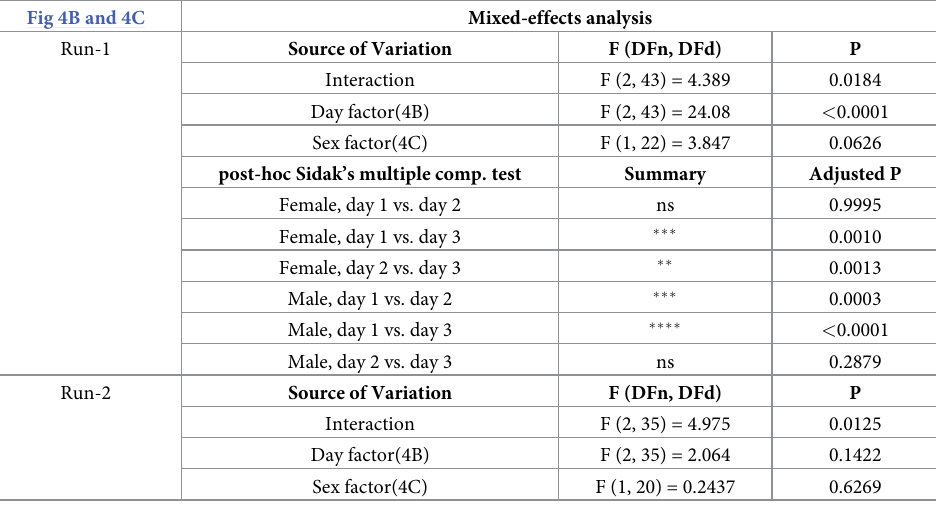
Table 4. Statistical analysis of data shown in Fig 4B and 4C for place learning, cohort A, Run-1, and Run-2. Fig 4B and 4C